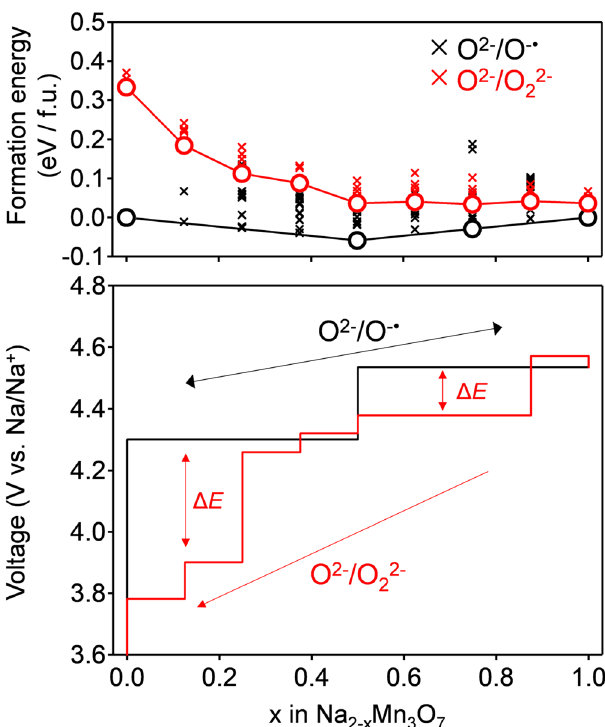
Fig. 5 Predicted voltage hysteresis of Na 2- x Mn 3 O 7 with hypothetical peroxide-like O 2 2 − dimers. DFT calculated convex hull and voltage pro fi le of Na 2- x Mn 3 O 7 with O − (cid:129) and with O 2 2 − . The formation energies of both pristine structures and peroxide phases were calculated relative to pristine Na 2 Mn 3 O 7 and NaMn 3 O 7 phases. Black and red crosses in the convex hull are formation energies of Na 2- x Mn 3 O 7 with O − (cid:129) and with O 2 2 − , respectively. Black and red circles are the lowest states at various desodiated states. The black solid line of the voltage pro fi le represents the charge/discharge curves without O 2 2 − formation, while the red solid line represents the discharge curve for hypothetical Na 2- x Mn 3 O 7 with O 2 2 −